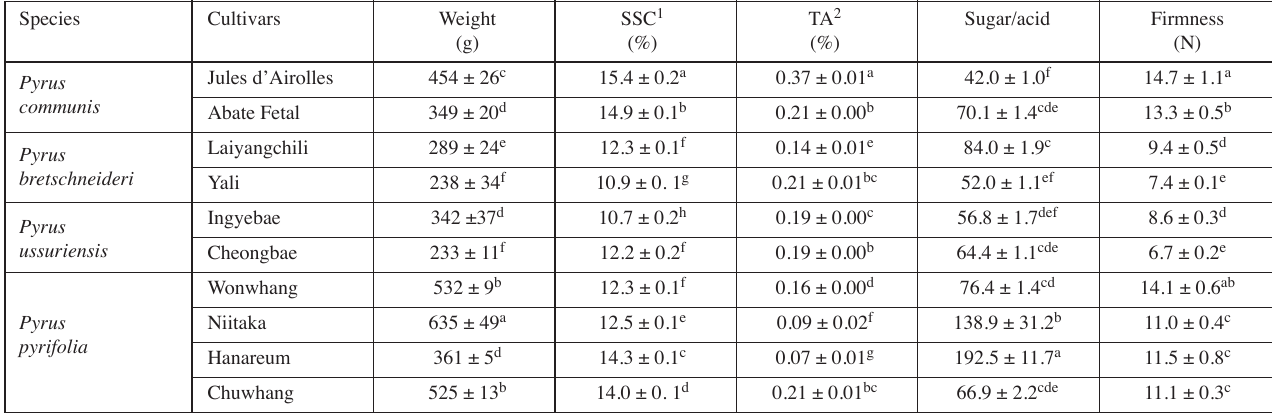
Tab. 1: Physiochemical properties of 10 different pear